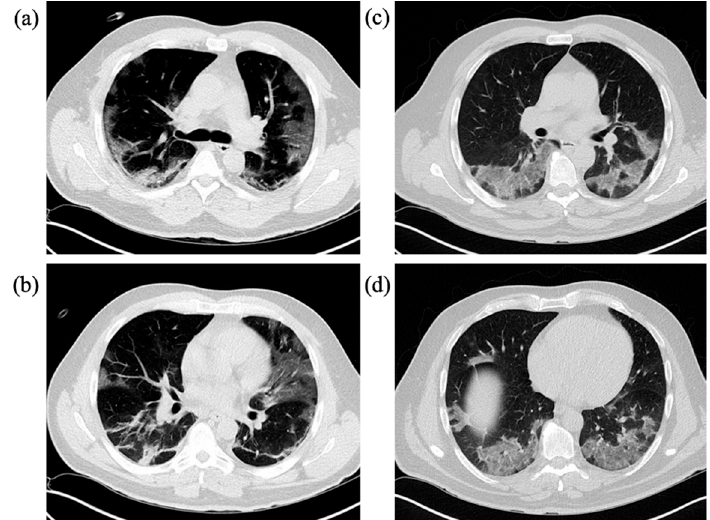
Figure 5. Representative cases with typical COVID-19 imaging features on chest CT in a group comparison. IV = Invasive ventilation group; non-IV = No/non-invasive ventilation group. ( a )/( b )